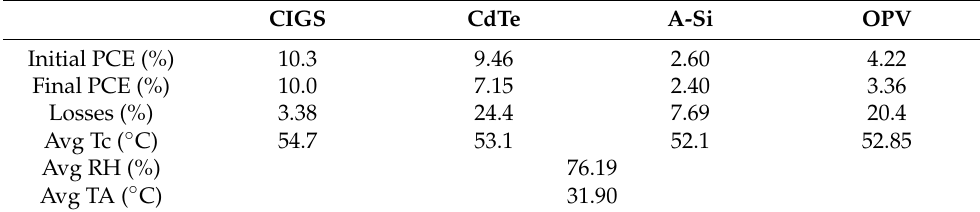
Table 6. PCE losses for PV technologies in PVMS1 after four months.